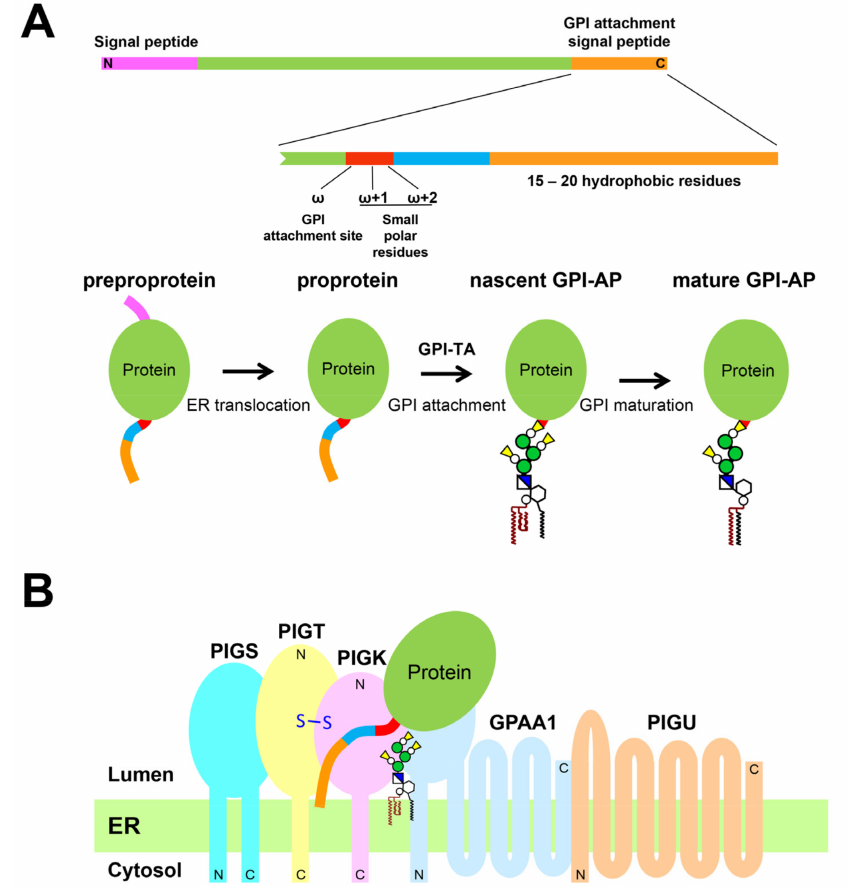
Figure 1. GPI attachment to proteins mediated by the GPI-TA complex. ( A ) Schematic representation of a GPI precursor protein that possesses an N-terminal signal peptide for ER translocation (pink) and a C-terminal GPI attachment signal (orange). The GPI-attachment signal consists of (1) ω , ω + 1, and ω + 2 amino acid residues with short side chains (red); (2) five to ten hydrophilic amino acids (blue); and (3) 15–20 hydrophobic amino acids at the C-terminus (orange). When a GPI precursor protein (preproprotein) is translocated into the ER, the N-terminal signal peptide is cleaved by signal peptidases. By reaction of the GPI-TA complex, the C-terminal GPI attachment signal is cleaved from proprotein at the ω -site, which is ligated to the preassembled GPI via an amide bond, generating a nascent GPI-AP. The GPI moiety is remodeled during transport, and mature GPI-AP is generated. ( B ) Schematic representation of the GPI-TA, which is a complex with five subunits localized on the ER membrane. PIGK is a catalytic subunit and forms an intermolecular disulfide bond with PIGT. GPAA1 may catalyze the formation of the amide bond between the ω -site and a bridging ethanolamine-phosphate (EtNP) on GPI. PIGU may be related to recognizing the GPI attachment signal or the lipid portion of GPI. The function of PIGS is still not